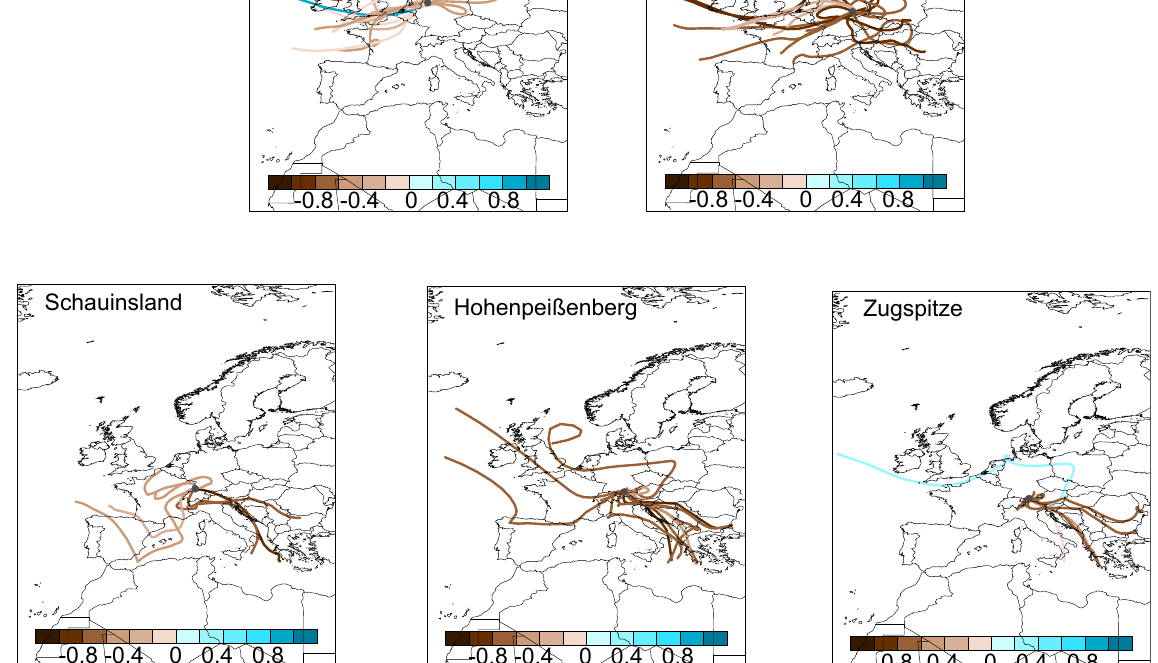
Figure 4. 72h back trajectories calculated from the model output (D01) for different observation sites in the GUAN network. The trajectories are coloured according to the MNB for individual observation